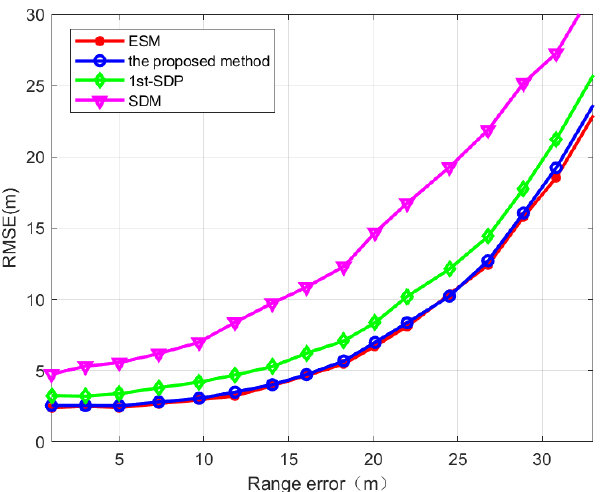
Figure 10. Comparison of RMSE variation with measurement error of different methods.